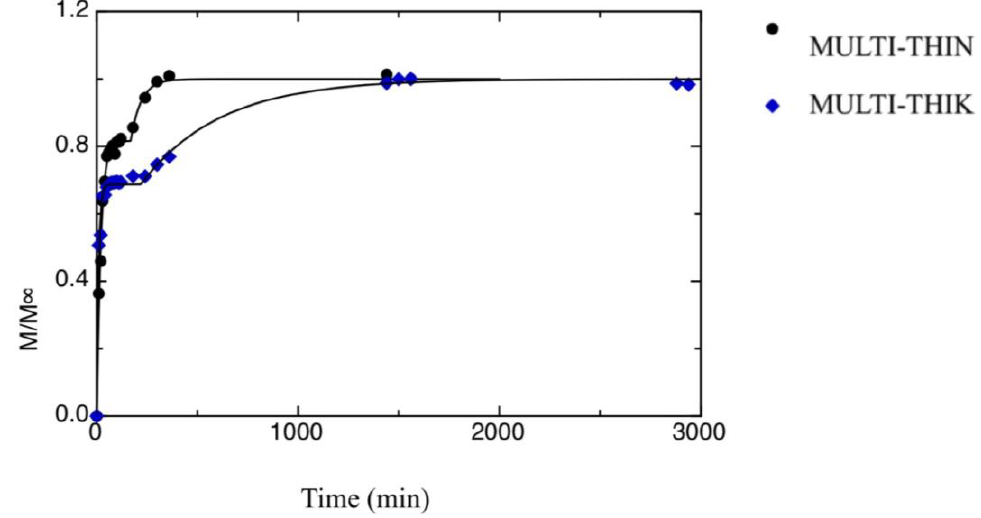
Figure 3. Release kinetics of SB in water from both MULT-THIN and MULT-THIK films, during the second stage of release. The curves in the figures represent the best fitting to the data.